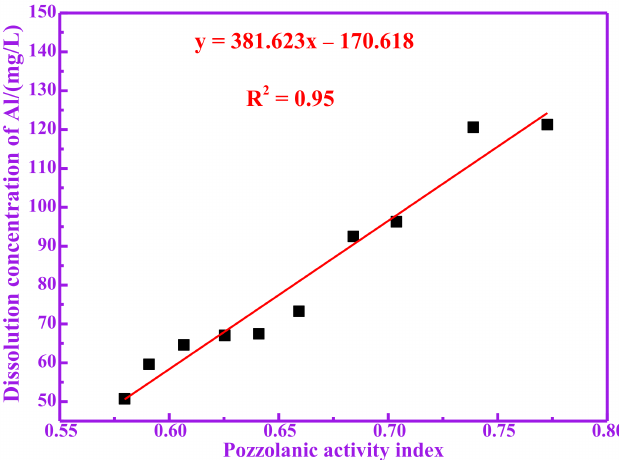
Figure 4. Correlation between dissolution concentration of Al and pozzolanic activity